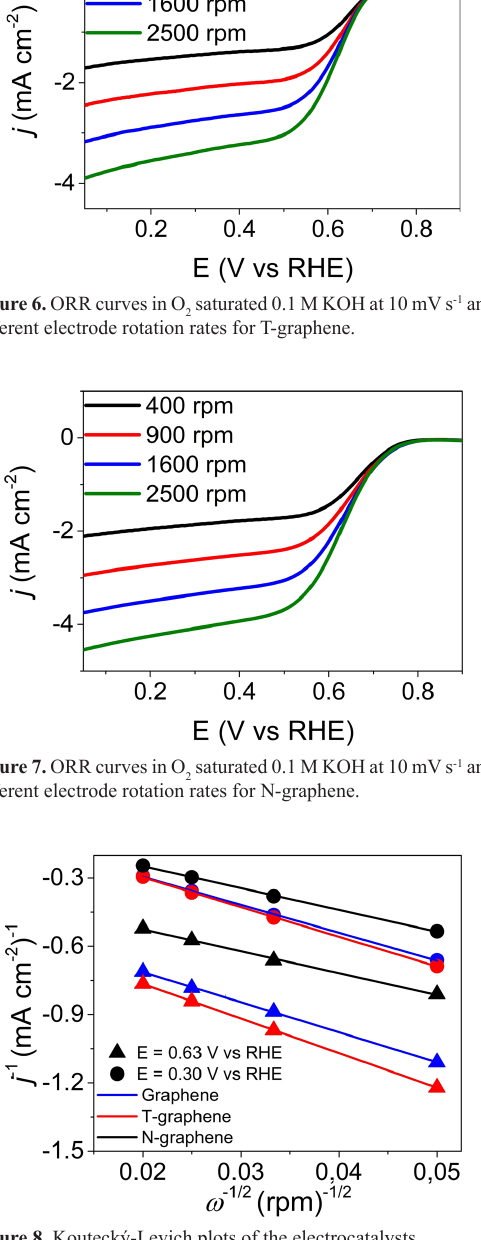
Figure 9. Tafel plots of the electrocatalysts at 1600 rpm.